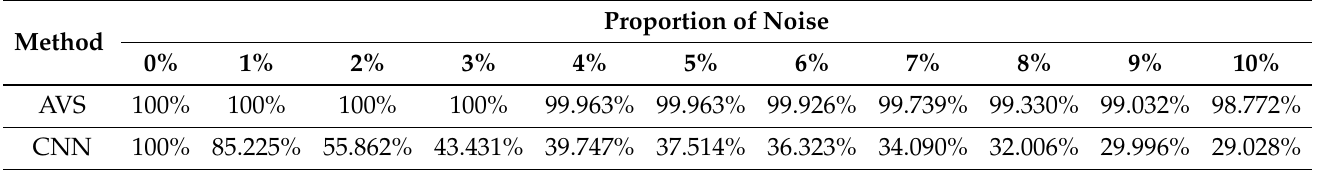
Figure 20. The structure of CNN used for orientation detection. Table 3. The recognition accuracy of AVS and CNN on ideal object